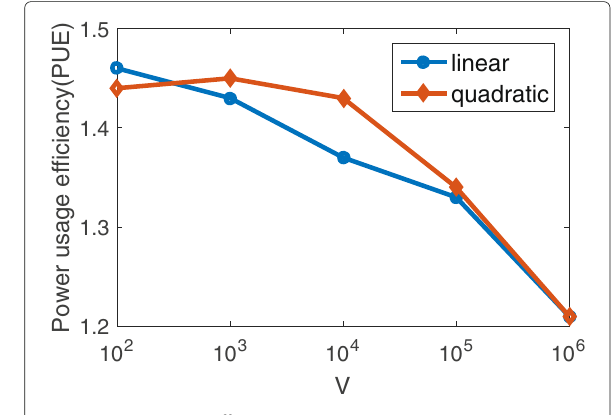
Fig. 11 Power usage efficiency vs.